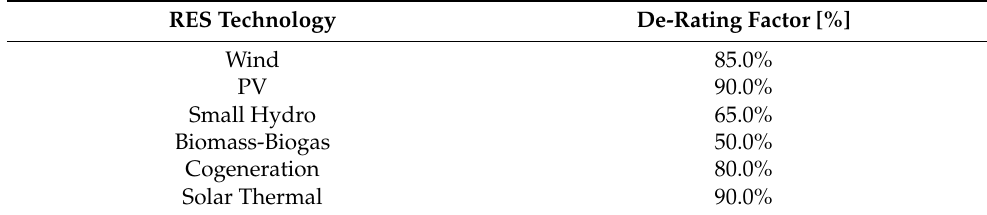
Table 2. RES units’ de-rating